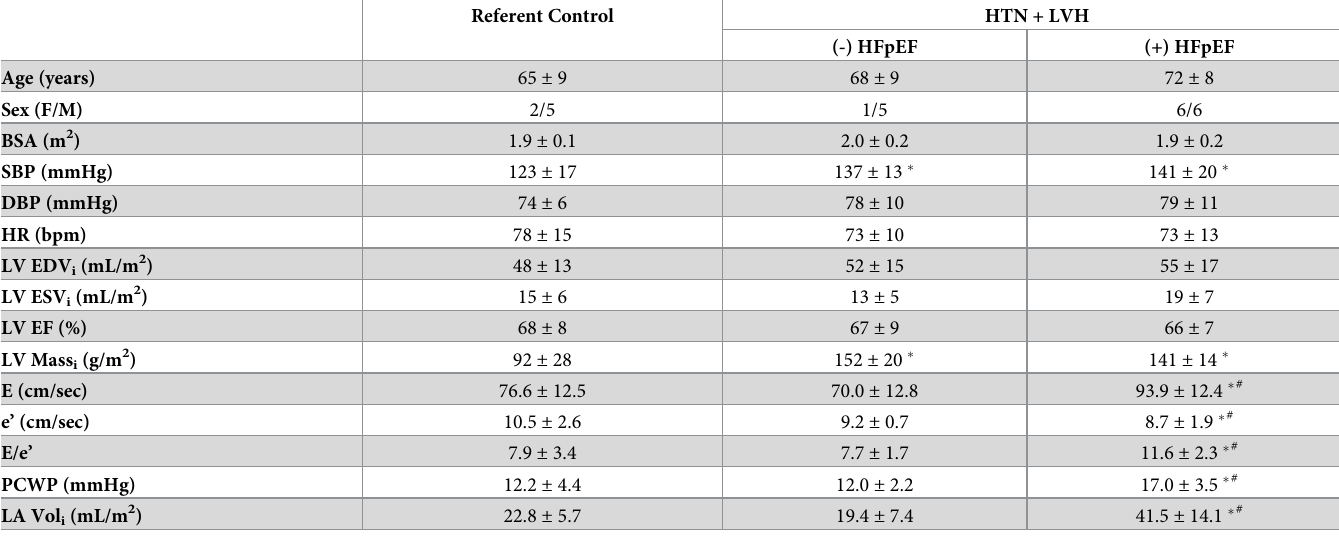
Table 1. Demographic, structural, and hemodynamic